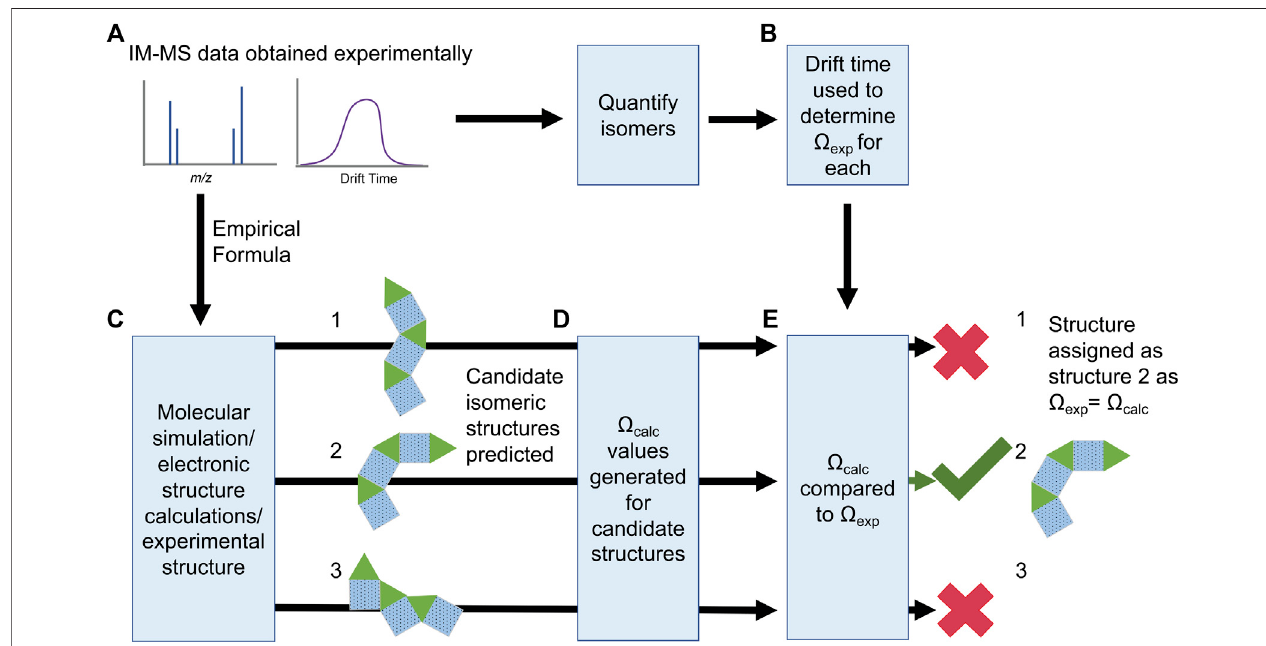
FIGURE 5 | IMS-MS data can provide (A) experimental drift times and masses. These can be converted to (B) Ω exp values and (C) empirical formula for structure prediction. The predicted structures can then have (D) Ω calc values predicted and compared to the Ω exp values to give (E) con fi dent structural assignment of the observed